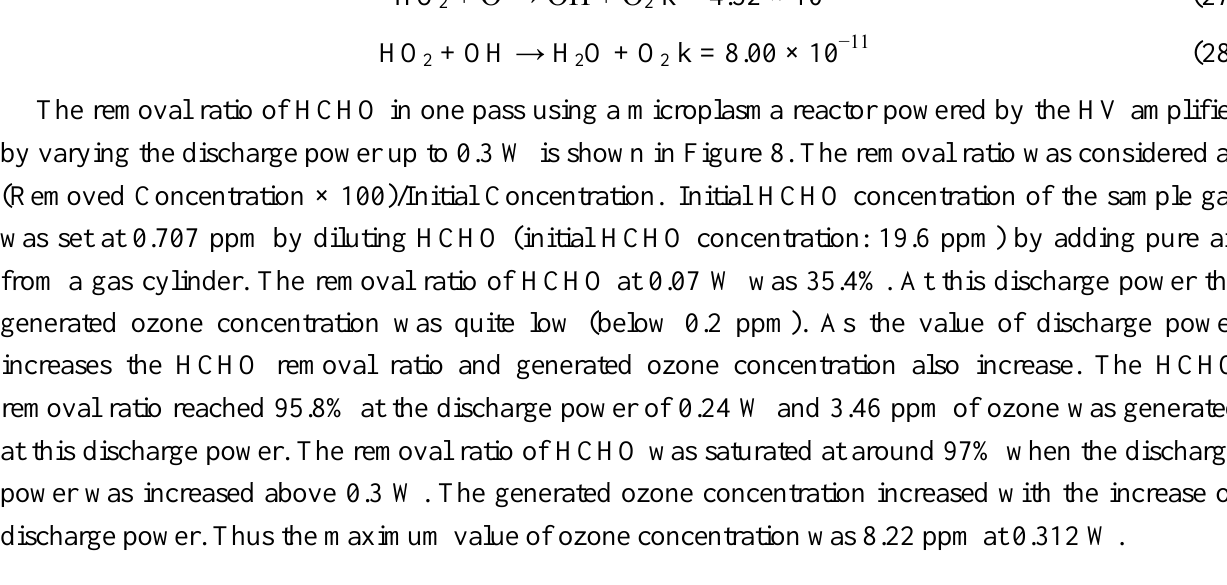
Figure 8. HCHO and O concentration in one pass treatment by HV 3